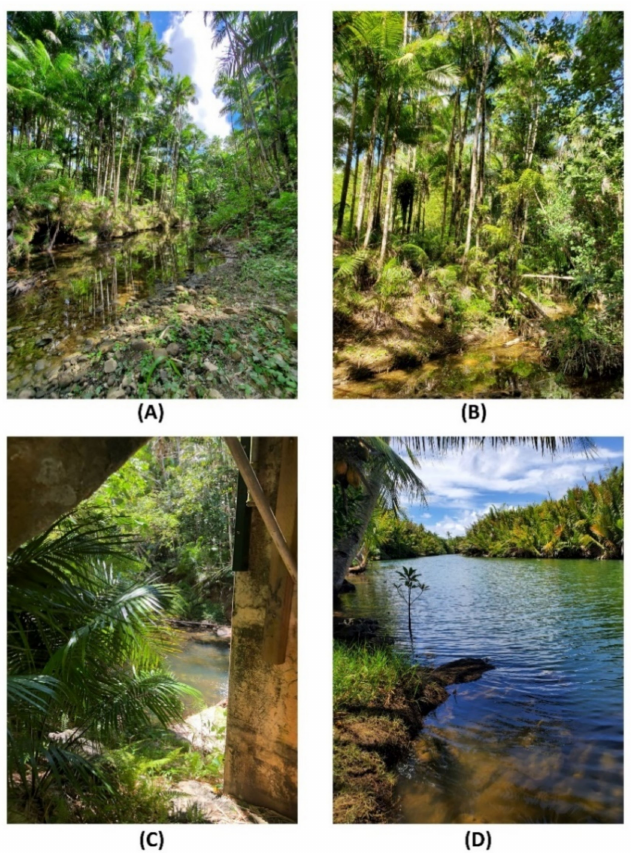
Figure 2. Photos for each sampling site. ( A ) upstream from Ordot Landfill, ( B ) downstream from Ordot Landfill, ( C ) USGS Pago River streamflow gauge, and ( D ) near Pago River